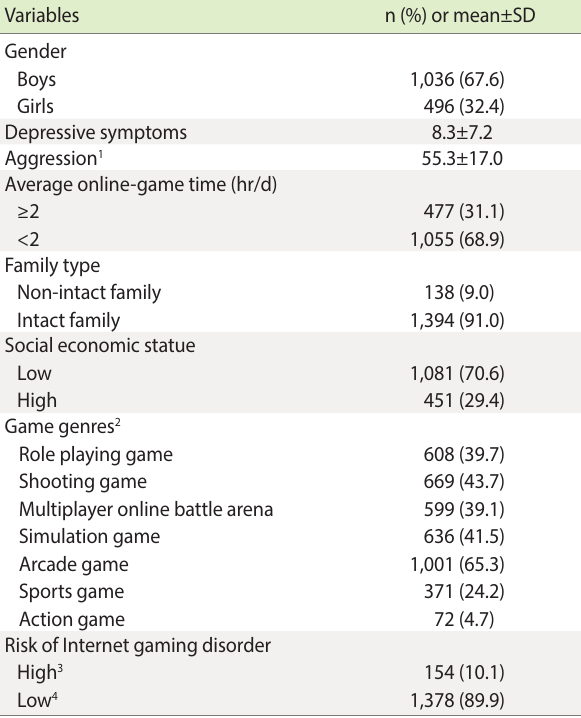
Table 1. General characteristics of 1,532 first-year middle school students in Korea